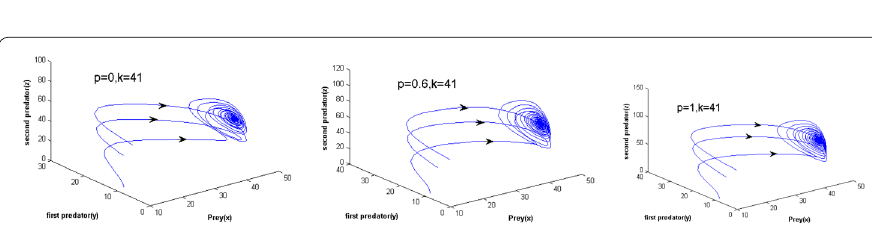
, y ∗ , z ∗ ) for different I 2 I 2 I 2